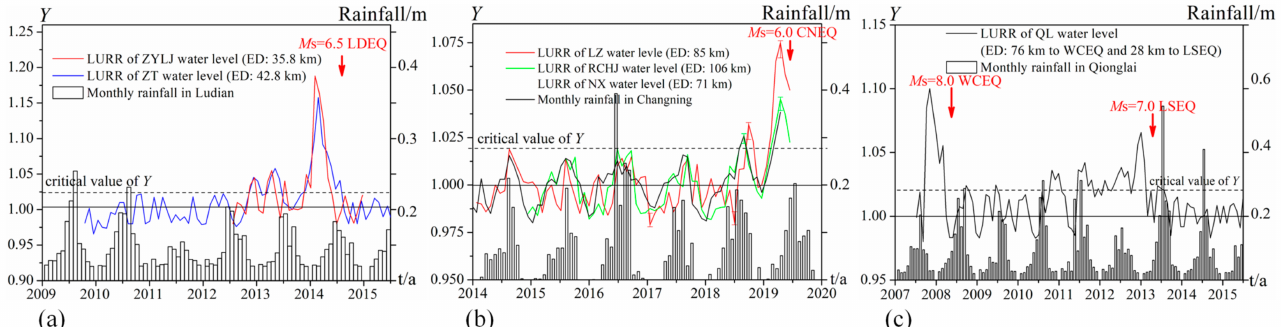
Figure 8. Time series of LURR produced with groundwater level in the wells shown in Figure 3. The curves in the maps are respectively for the LDEQ ( a ), CNEQ ( b ) and WCEQ ( c ), with the time of the mainshocks shown by a vertical arrow. The monthly rainfall in the Ludian, Changning and Qionglai districts are also shown in the maps. The focal mechanism solutions adopted to calculate CFS are: LDEQ: strike = 340, dip = 86, slip = − 9, depth = 14, CNEQ: 207, 88, − 177, 12, and WCEQ: 231, 35, 138, 13. ED: Epicentral distance. The error bars of some LURR peaks due to annual changes are also shown in ( b